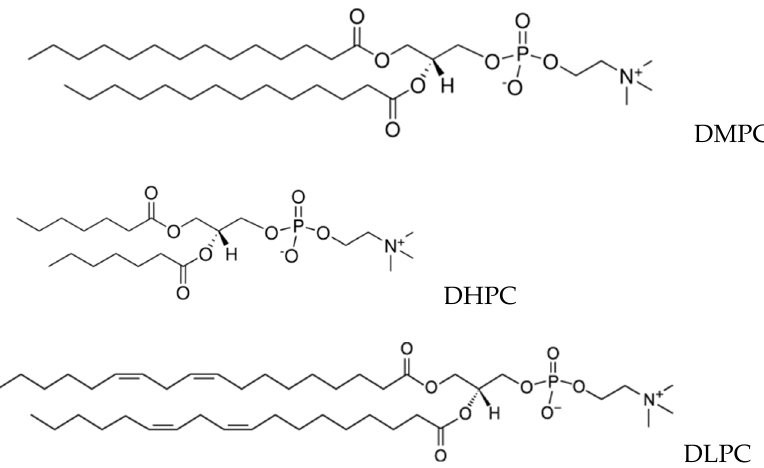
Figure 2. Structures of lipids DMPC (1,2-dimyristoyl-sn-glycero-3-phosphocholine), DHPC (1,2- diheptanoyl-sn-glycero-3-phosphocholine and DLPC (1,2-dilinoleoyl-sn-glycero-3-